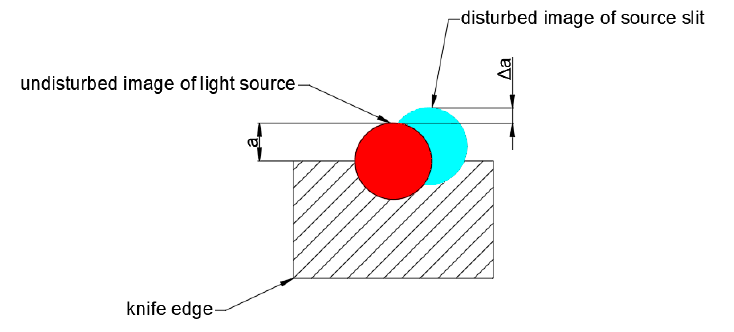
Figure 18. Knife edge working principle.